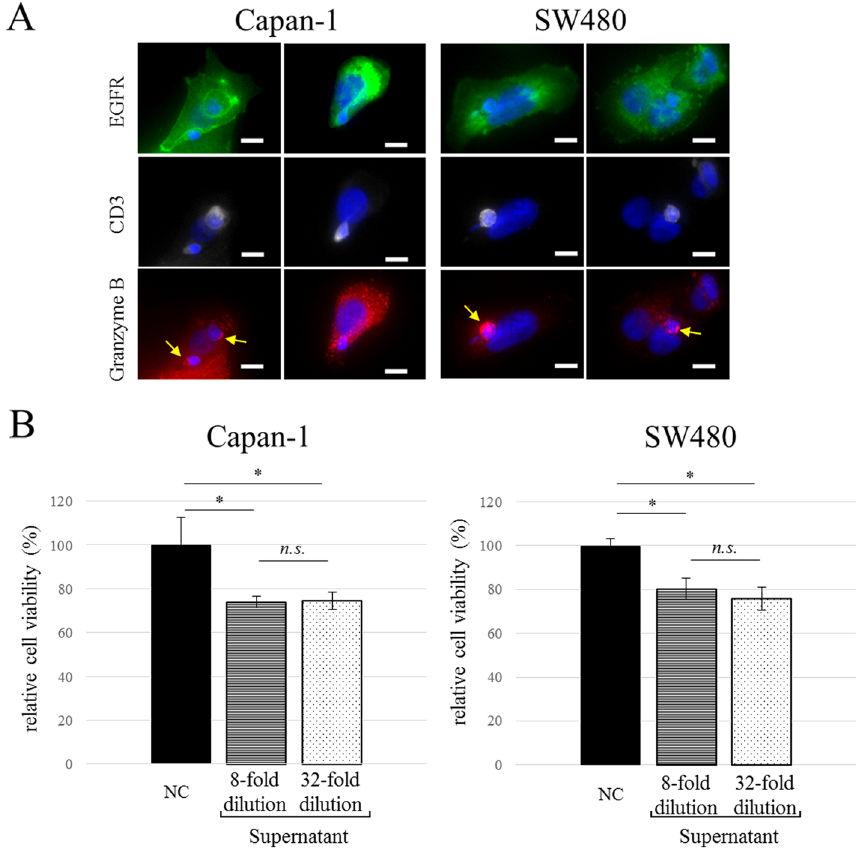
Figure 3. Direct and indirect tumor cell killing. ( A ) Two representative images of granzyme B production by CD3 + T cells in contact with Capan-1 or SW480 cells. DAPI, blue; EGFR, green; CD3, white; granzyme B, red. Arrow (yellow) indicates granzyme B expression in CD3 + T cells. Scale bar = 10 µm. ( B ) Cell-killing activity of the supernatant of mixed immune cells against Capan-1 and SW480 cells ( n = 3). The data are shown as means ± SD. n.s . not significant. * p < 0.005 (one-way ANOVA with Tukey